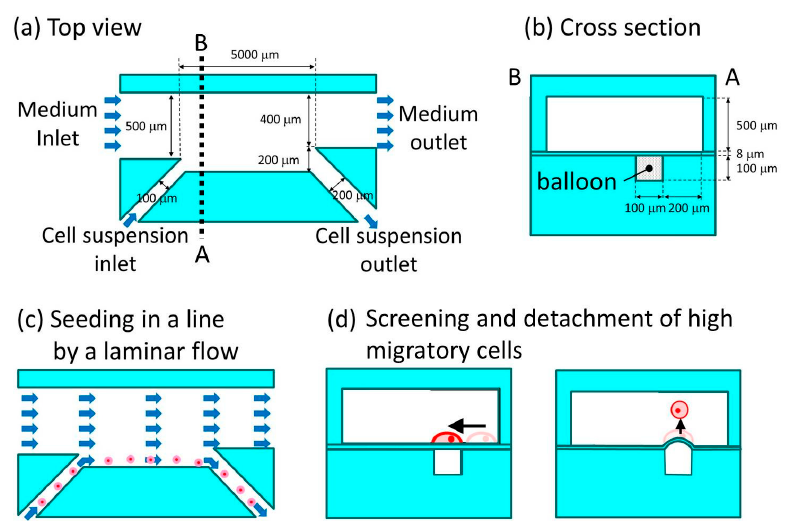
Figure 2. Microfluidic high-migratory cell collector. ( a ) Top view and ( b ) cross section of the microfluidic device and its specifications. ( c ) Seeding cancer cells in a line pattern by laminar flow. ( d ) Screening for high-migratory cancer cells, and detachment of the cells by the expansion of a balloon.